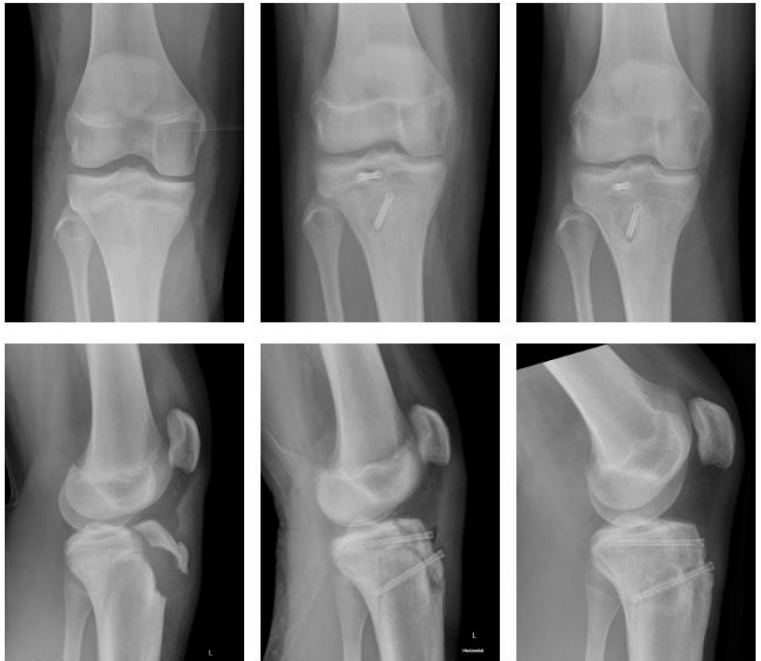
Figure 1. Fracture of tibial tuberosity with Magnezix ® screw: preop, 2 months postop, 10 months postop (left to right). Polymer (Figure 2).